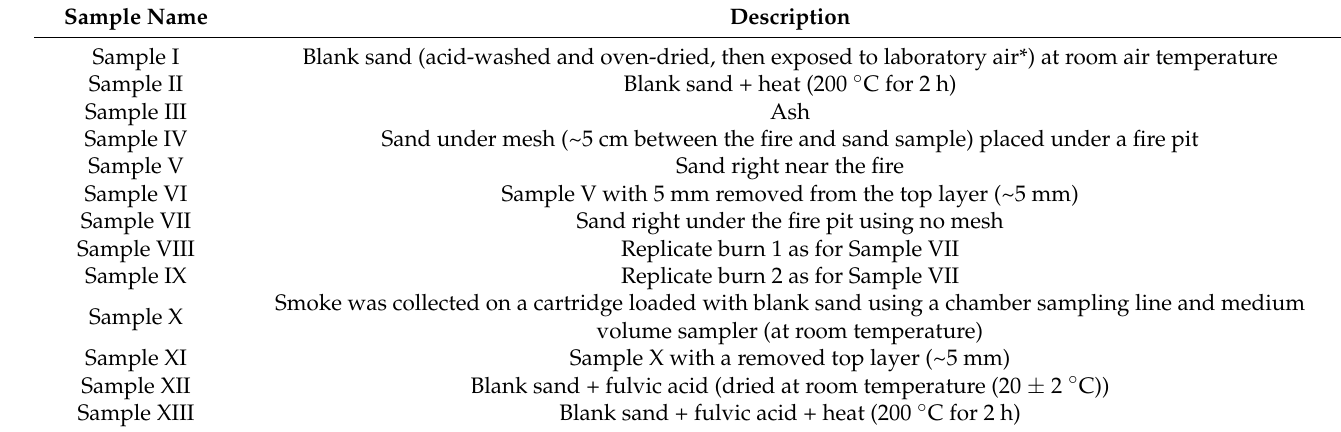
Table 1. Tested sand and ash samples and descriptions of the treatments (*ambient relative humidity in the laboratory was 15 ±